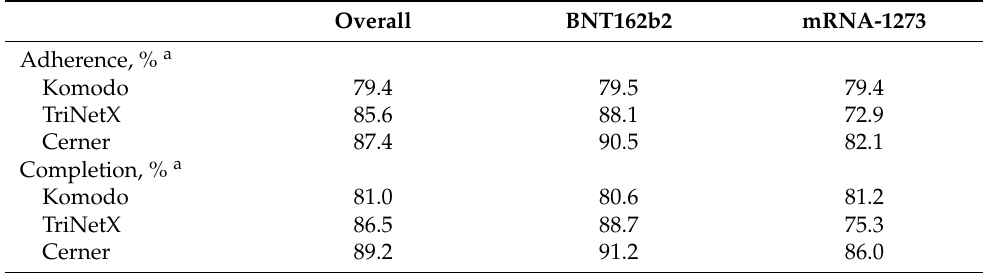
Table 1. Adherence and completion in the Komodo, TriNetX, and Cerner